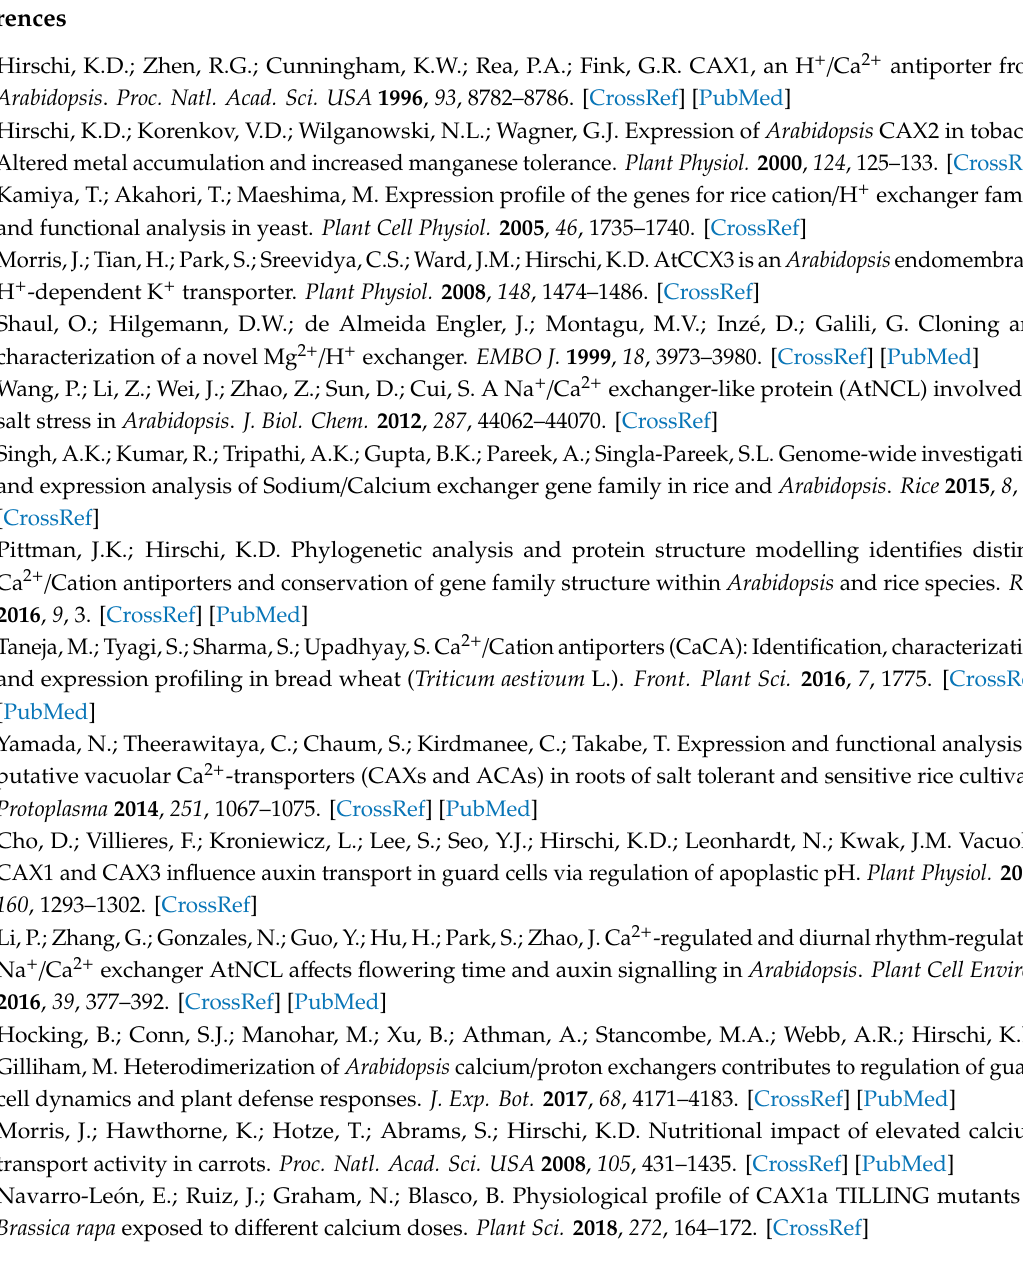
TMHMM; Figure S4: Multiple alignments of conserved α 1-repeat and α 2-repeat regions in CAX proteins; Figure S5: Multiple alignments of conserved α 1-repeat and α 2-repeat regions in CCX proteins; Figure S6: Multiple alignments of conserved α 1-repeat and α 2-repeat regions in MHX proteins; Figure S7. Multiple alignments of conserved and α 2-repeat regions in NCL proteins; Table S1: List of primers used for sequence analysis of SlCaCA ; Table S2: List of primers used for expression analysis of SlCaCA